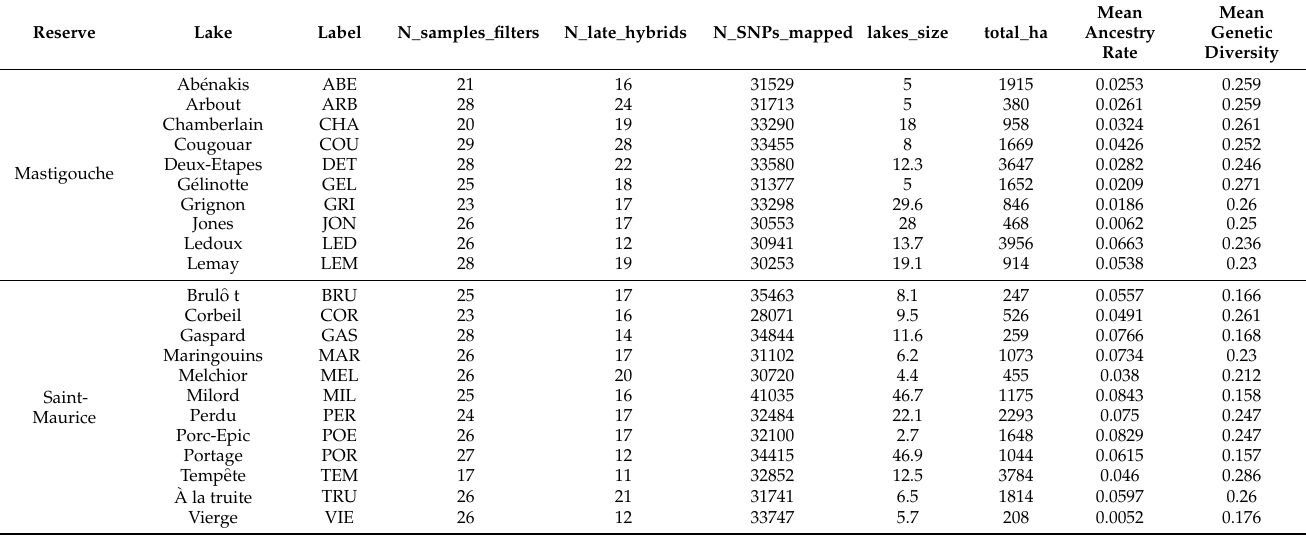
Table 1. Description of the 22 sampled Brook Charr lakes in Qu é